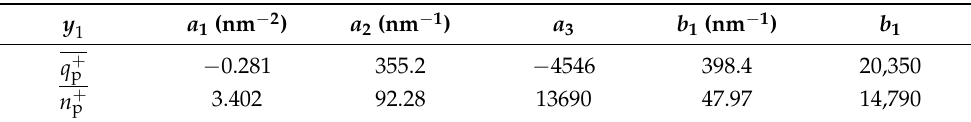
Figure A1. Average charge number per (positive-charged) particle and normalized (positive-charged) particle number of a nebulized NaCl aerosol. Table A3. Fitted values using Equation (A3) for the average normalized fraction (open squares, broken line) and for the average charge number (open circles, full line), respectively, of the positive-charged particles shown in Figure A1.